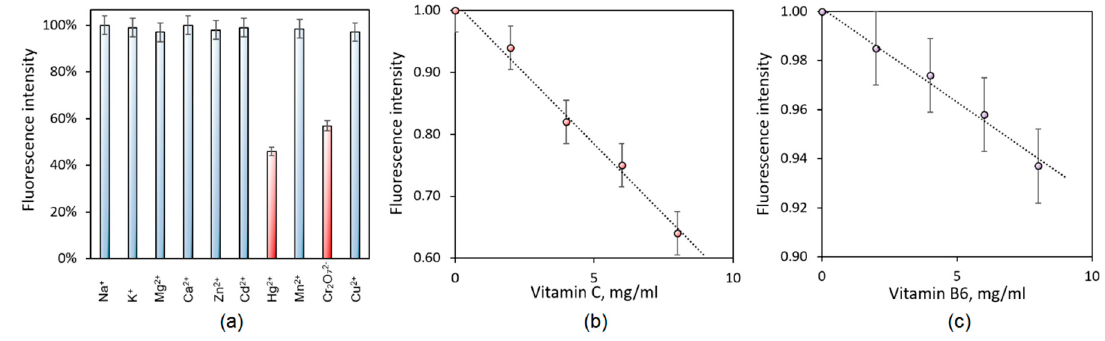
Figure 8. Detection of metal ions and vitamins by CQDs: ( a ) metal ions; ( b ) Vitamin C; ( c ) Vitamin B 6 .